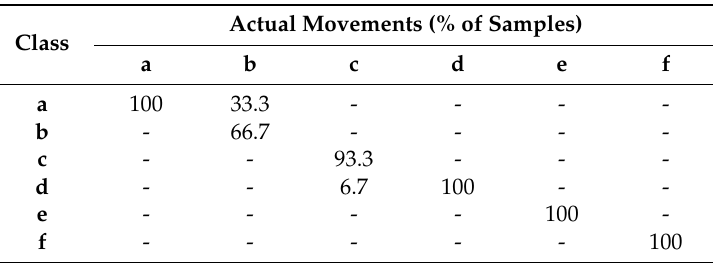
Table 1. Confusion matrix of experiment